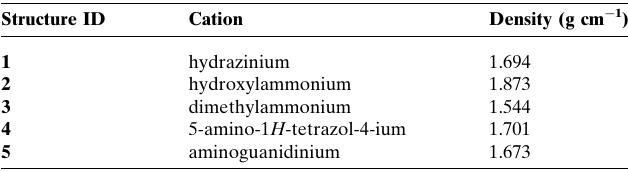
Table 6 Crystal densities of each